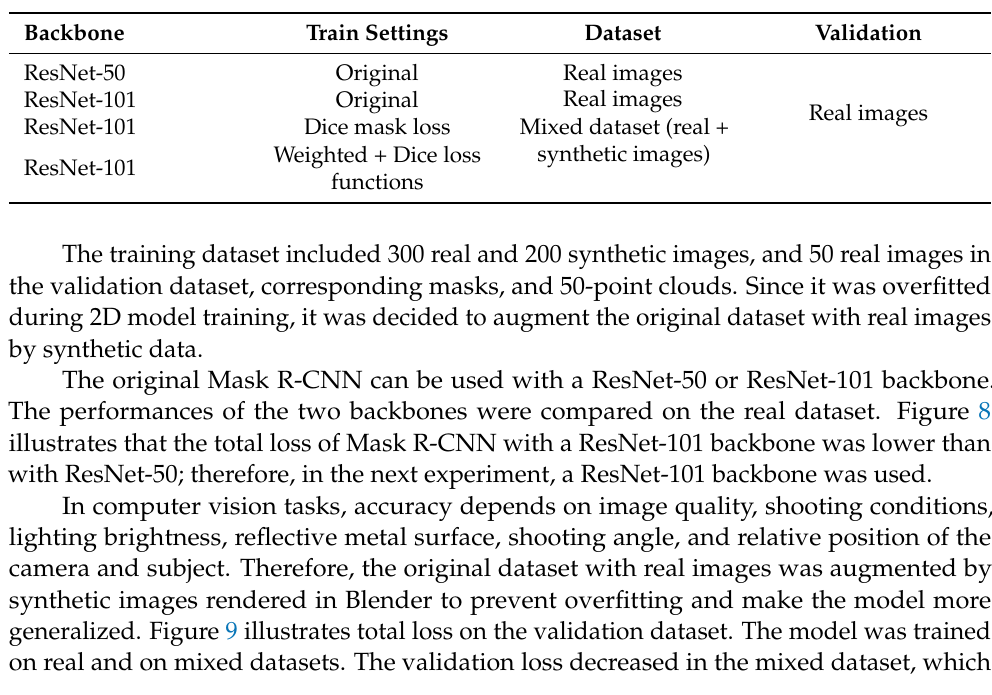
Table 3. Mask-RCNN model settings and